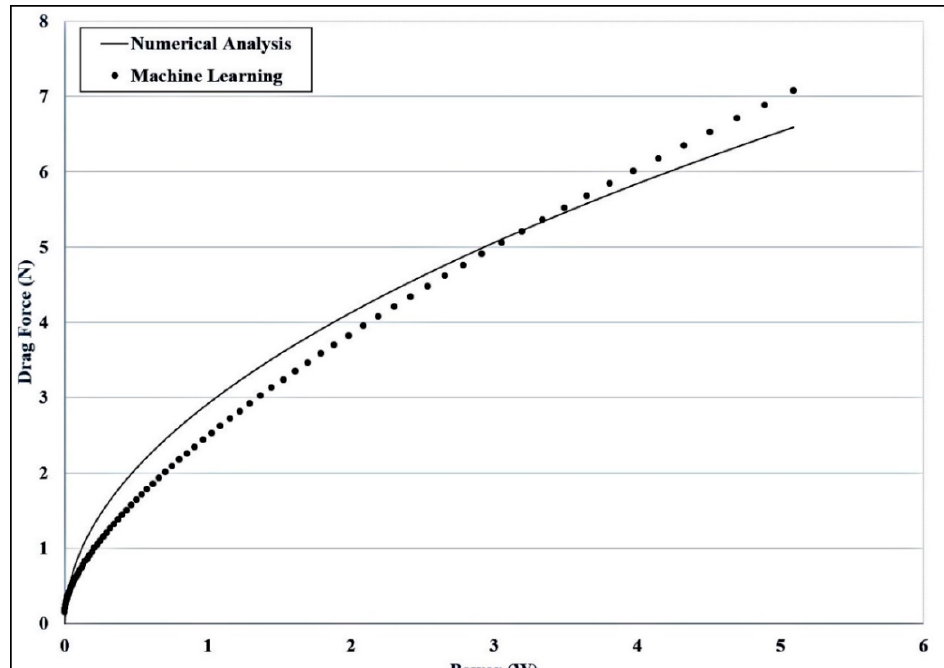
Figure 12. The effect of increasing the produced power on drag force.